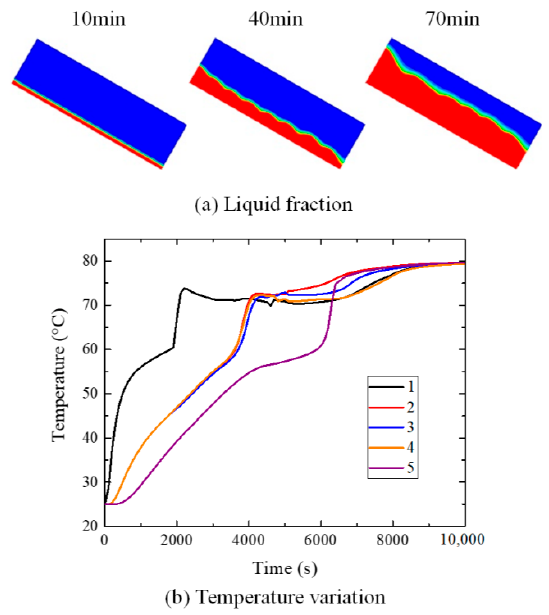
Figure 9. The melting process of paraffin at 0°. ( a ) Liquid fraction; ( b ) temperature variation.